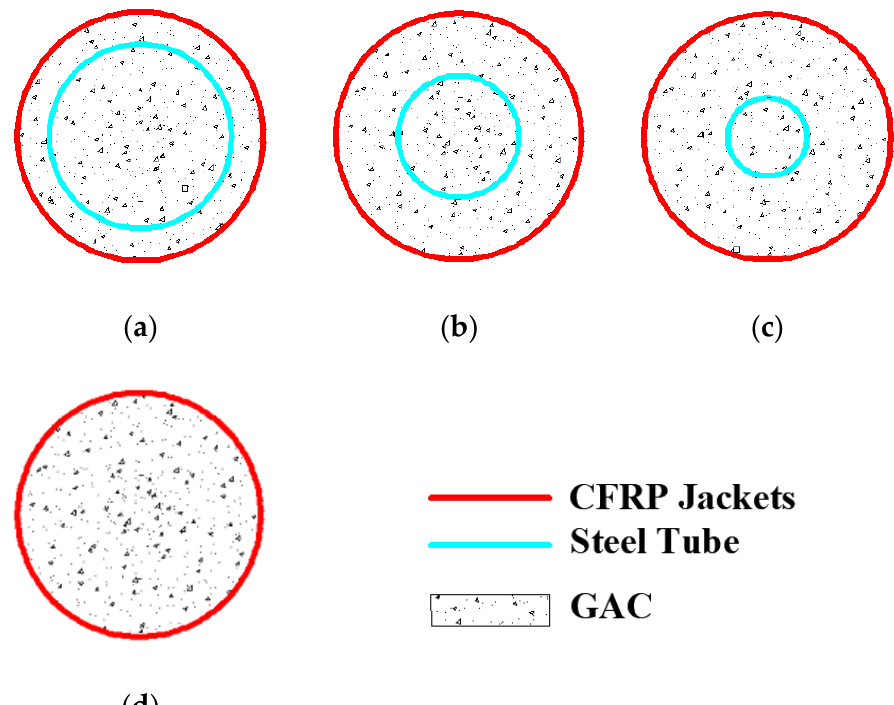
Figure 4. Schematic diagram of the cross-section of the test specimens: ( a ) ϕ = 0.74; ( b ) ϕ = 0.49; ( c ) ϕ = 0.32; ( d ) ϕ = 0.